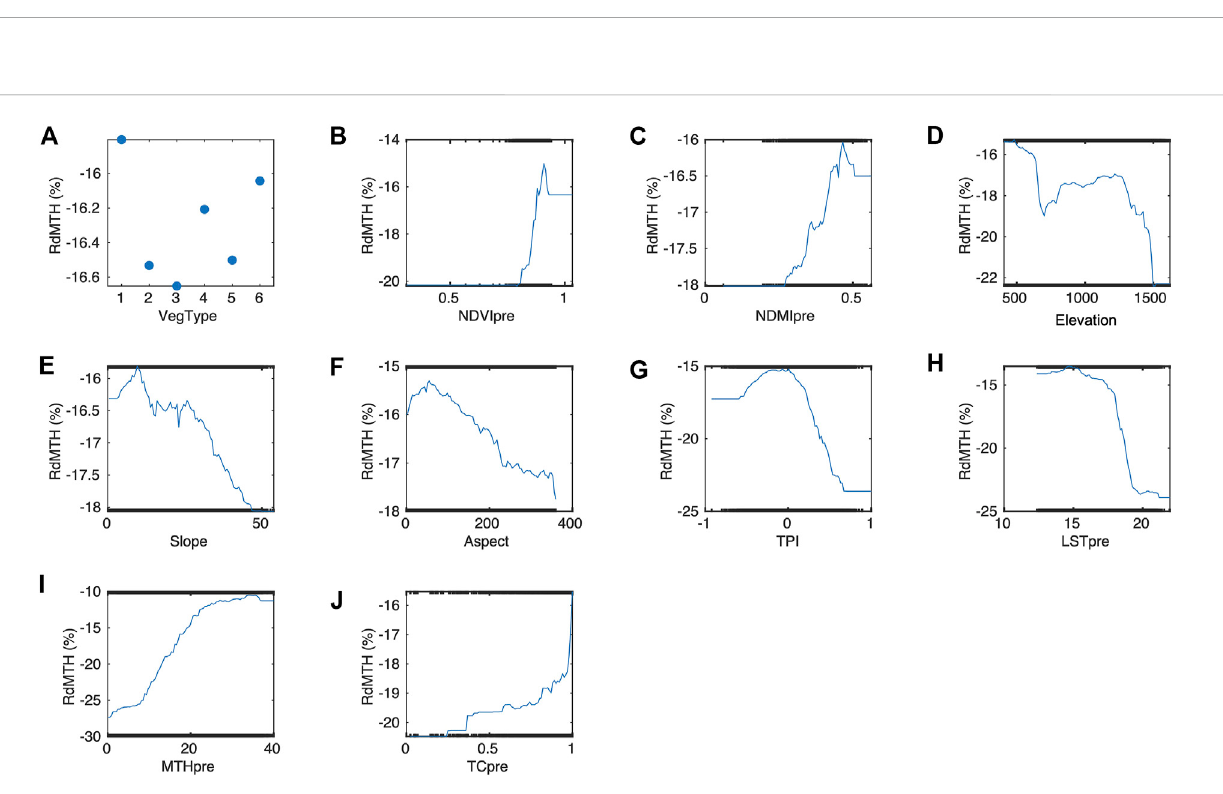
FIGURE 5 Partial dependence plots of explanatory variables ( n = 10) on regulating RdMTH of the CT2 fi re in Great Smoky Mountains National Park: (A) Vegetationtype, (B) NDVI pre , (C) NDMI pre , (D) Elevation, (E) Slope, (F) Aspect, (G) TPI, (H) LST pre , (I) MTH pre ,and (J) TC pre .Inpanel (A) ,numbersstandforsix vegetation type classes, i.e., HF, COF, YPF, OHF, NHF/AHF, and others,